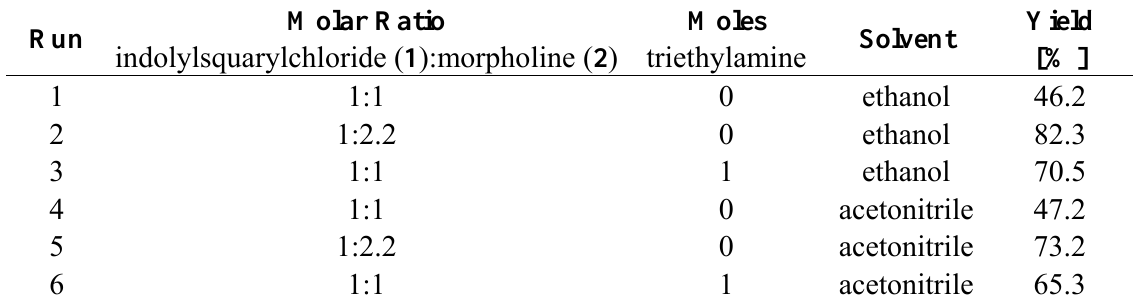
Table 1. Conditons and reagents for optimization of synthesis